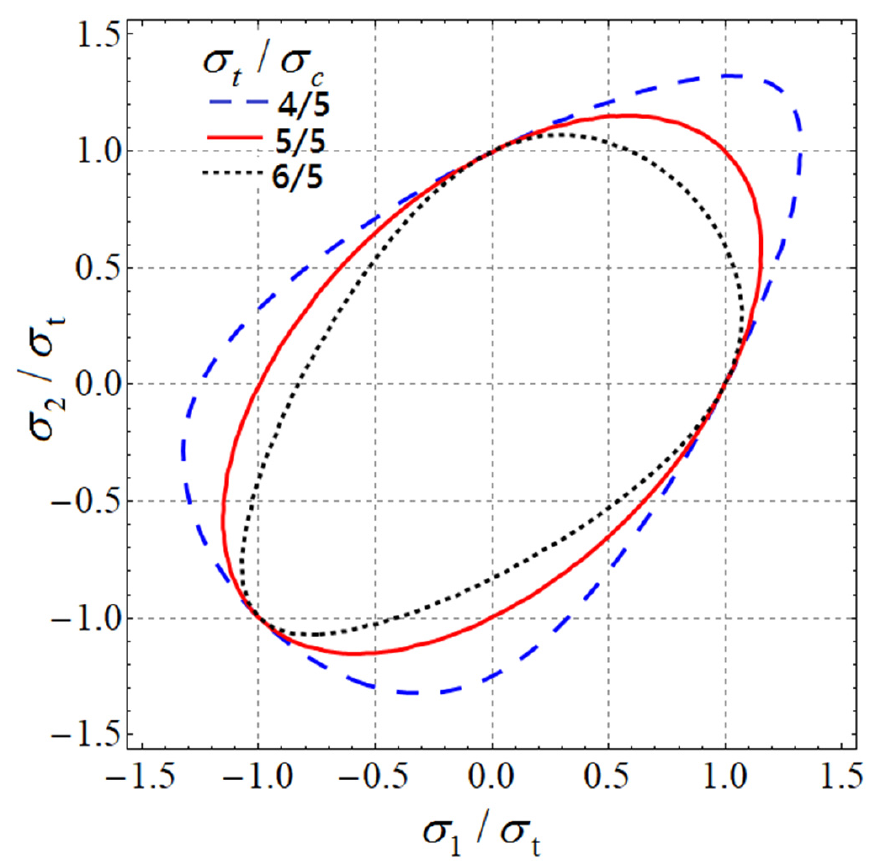
Figure 1. Yield loci predicted by the criterion (Equation (7)), according to σ t / σ c = 4/5, 5/5 (von Mises) and 6/5.